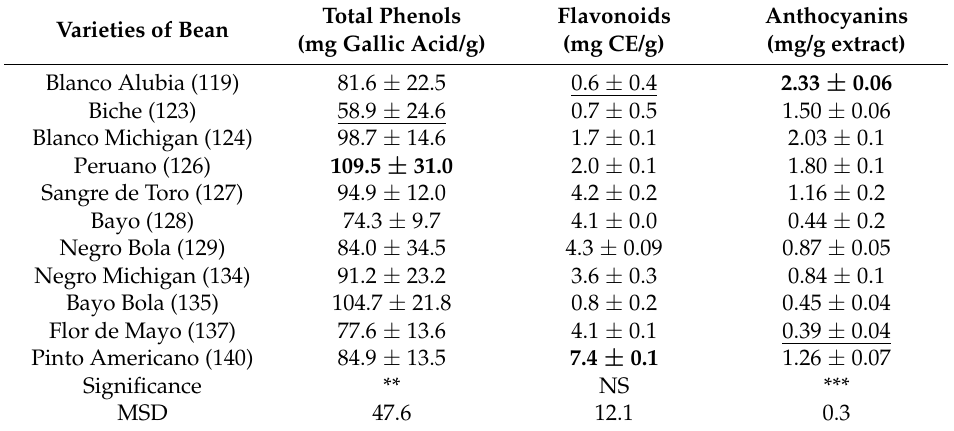
Table 7. Bioactive compounds in bean varieties produced and consumed in the State of